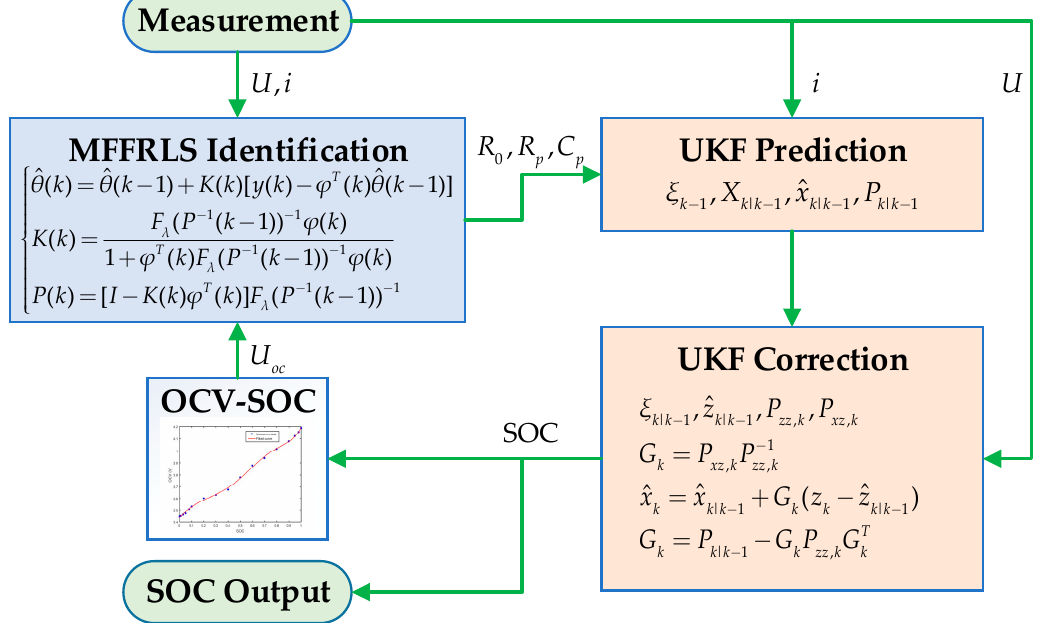
Figure 2. Diagram of the multiple forgetting factor recursive least square-unscented Kalman filter (MFFRLS-UKF) scheme.